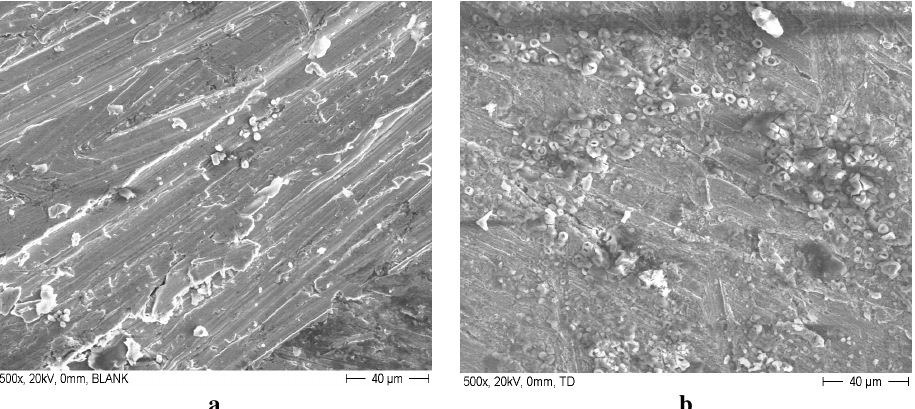
Figure 7 - SEM image of mild steel (a) in 0.5N HCl medium, (b) with C1 inhibitor